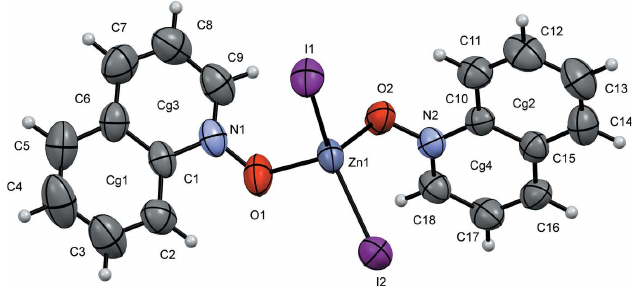
Figure 3 A view of compound ( III ), showing the atom labeling. Displacement ellipsoids are drawn at the 50% probability level.